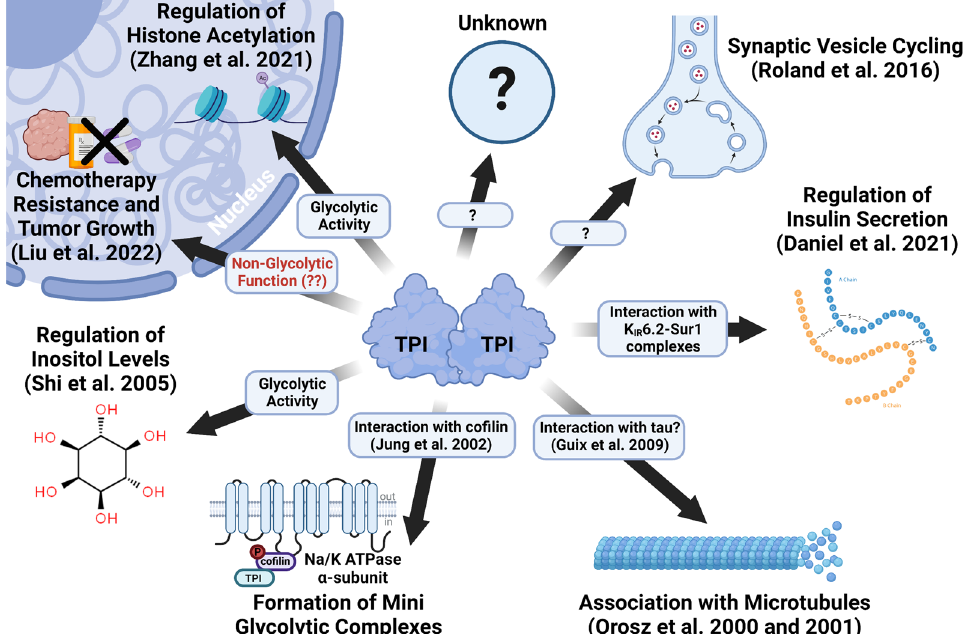
Fig. 2 Published functions of triosephosphate isomerase (TPI) that possibly represent moonlighting. Specific functional effects of TPI are described at each node, as well as the proposed mechanism underlying this function, if known. Designated in red text is the conclusion drawn by Liu et al. (2022), which has not yet been supported experimentally. Figure created using